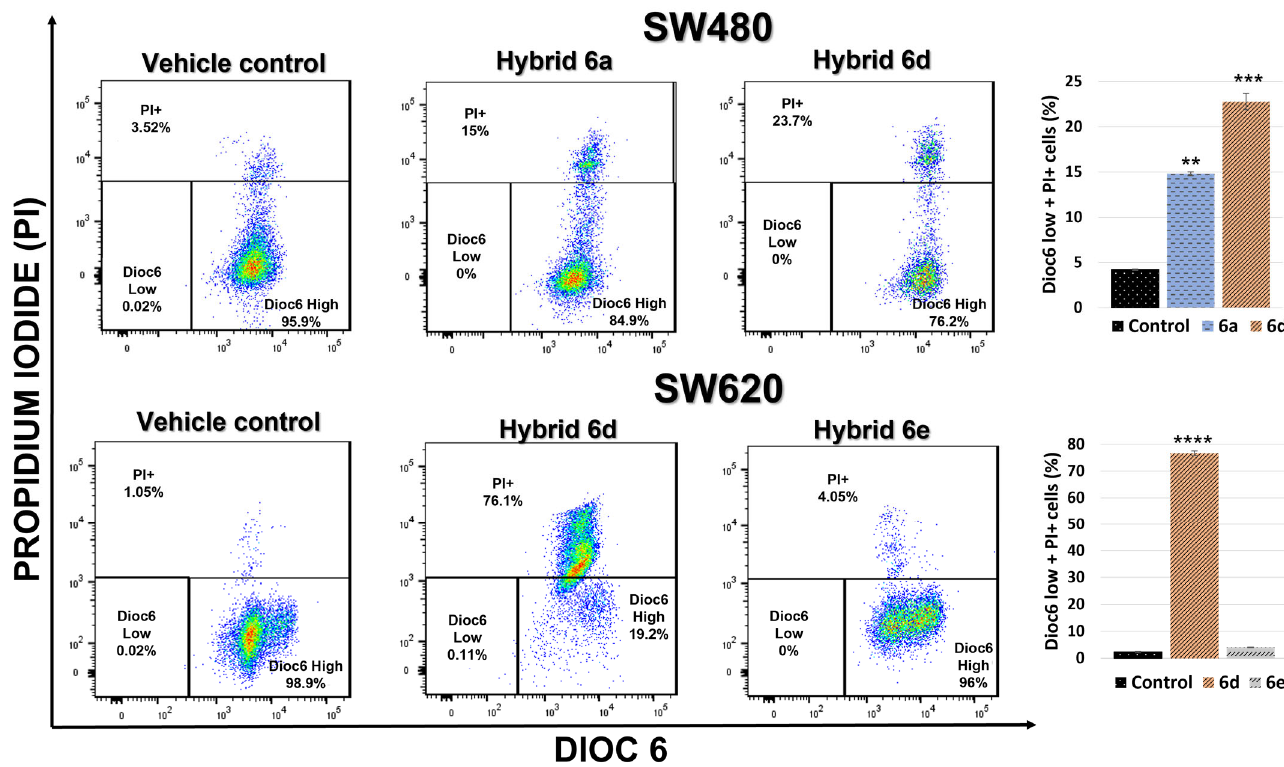
Figure 8. Changes in ∆Ψ m and plasma membrane integrity. Treatment with hybrids 6a and 6d in SW480 and hybrids 6d and 6e in SW620 cells. PI+: PI-positive cells, with membrane damage or dead cells; DiOC6 High: live cells with high membrane polarization; DiOC6 Low: cells in latency that lose membrane polarization. Data are presented as the mean of these two populations ± SE of three independent experiments. p values lower than 0.05 were considered statistically significant (** p < 0.01; *** p < 0.001; **** p < 0.0001).